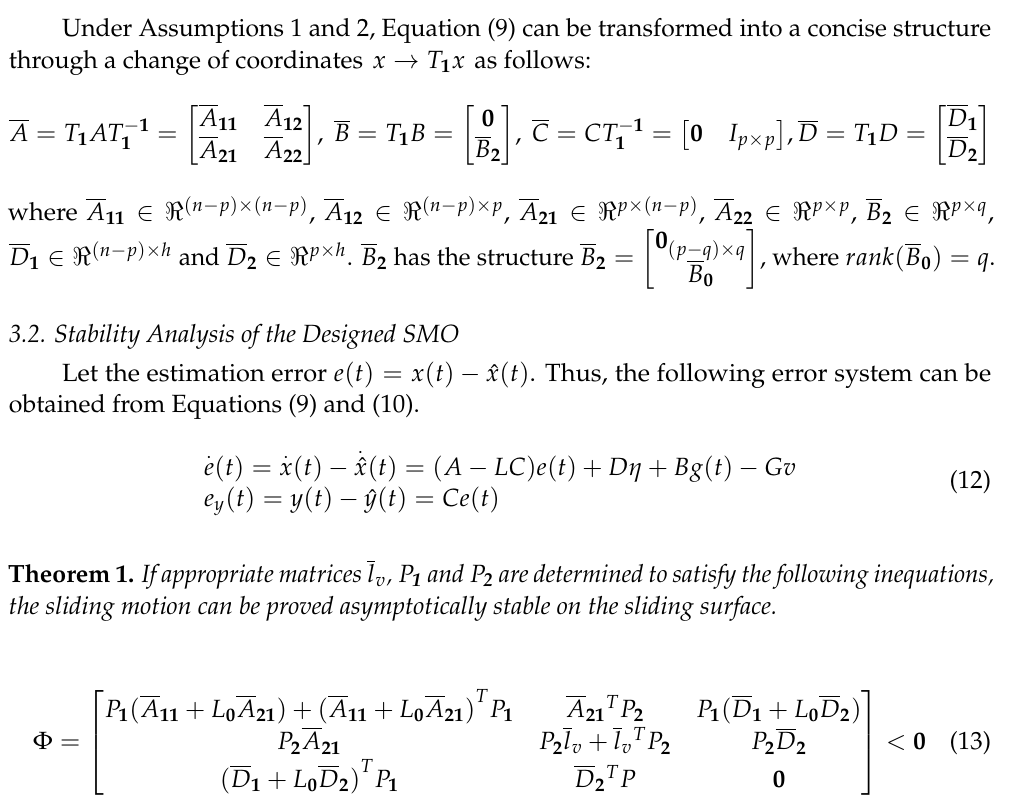
Figure 1. Flow chart of the proposed SMO on the attitude control system of the HSV.